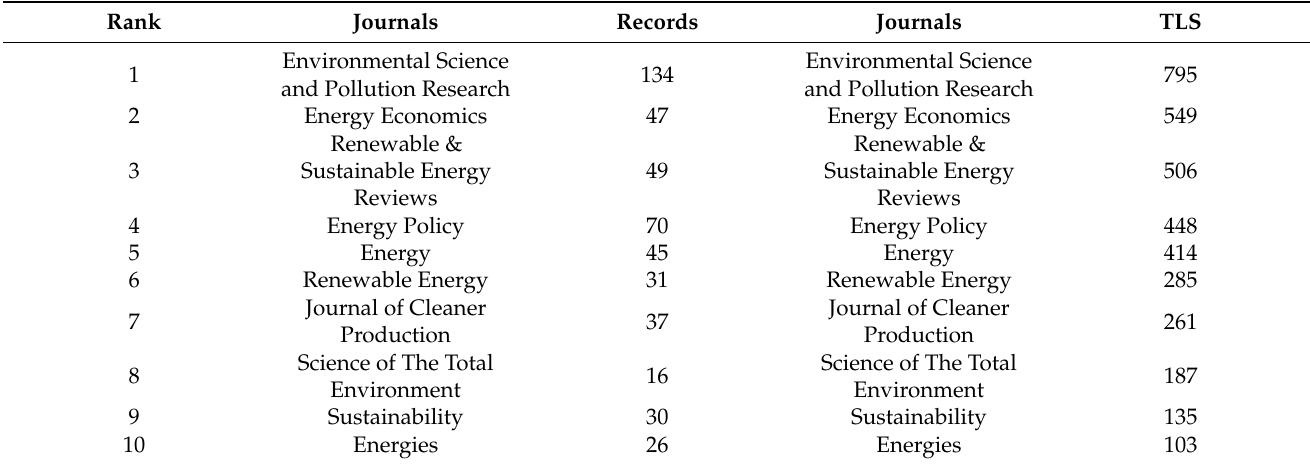
Table 2. Top 15 journals for number of documents and total connection